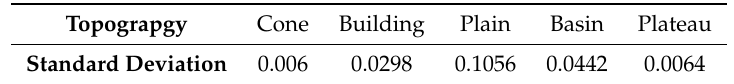
Table 2. The standard deviation of kurtosis corresponding to various topography (including Cone, Building, Plain, Basin,